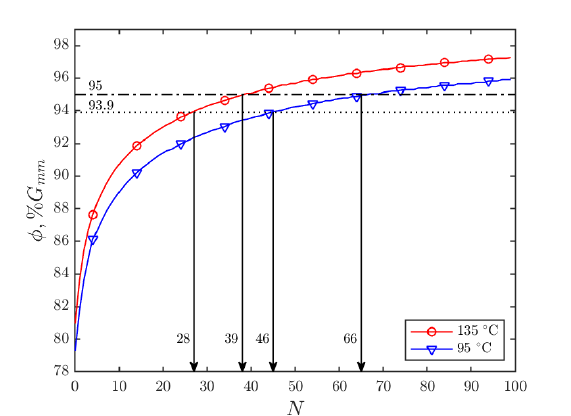
Figure 8. Calculation of the number of gyrations needed for achieving the two density levels for